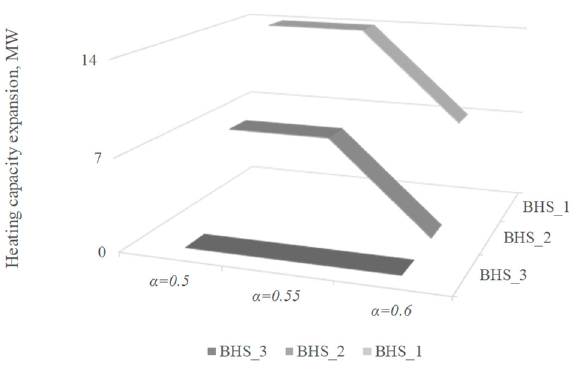
Figure 7. Heating capacity expansion scheme for each BPHS under different α values.